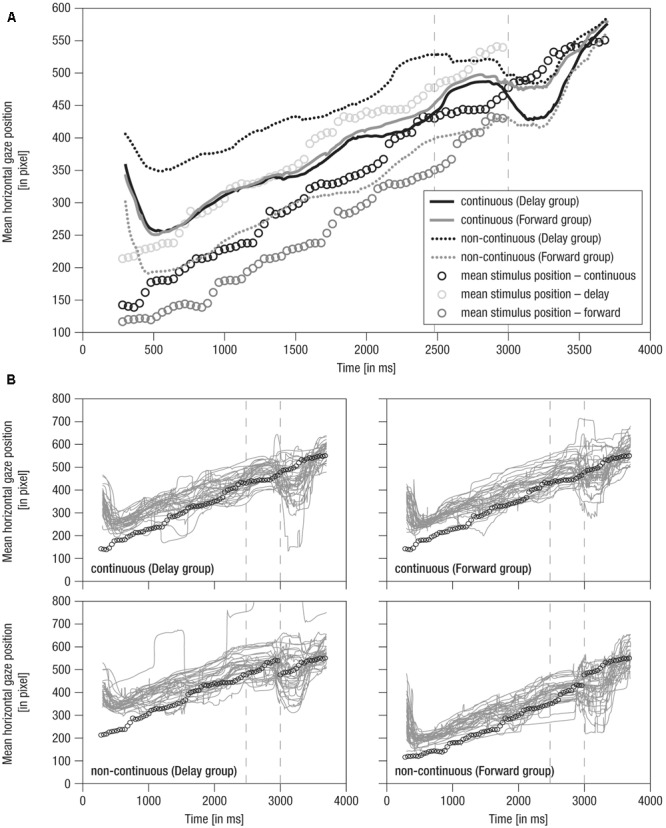
Mean horizontal gaze positions over time. (A) Grand averaged horizontal gaze positions over time. Lines: Solid – continuous, Dotted – non-continuous movement, Black – Delay group, Gray – Forward group, Vertical dashed – occlusion on- and offset. (B) Single averaged horizontal gaze positions over time (gray). Note that circles indicate mean stimulus position over time for the respective condition. Prior to occlusion, circles are horizontally shifted by ± 500 ms due to stimulus design. Gaze positions in continuous conditions match because the stimulus was identical. As the stimulus was not visible during occlusion (i.e., 2480–3000 ms), here, circles indicate imaginary continuation of the movement. Following occlusion (i.e., 3000–4000 ms), only circles for the continuous condition are plotted as the stimulus was identical in all conditions.